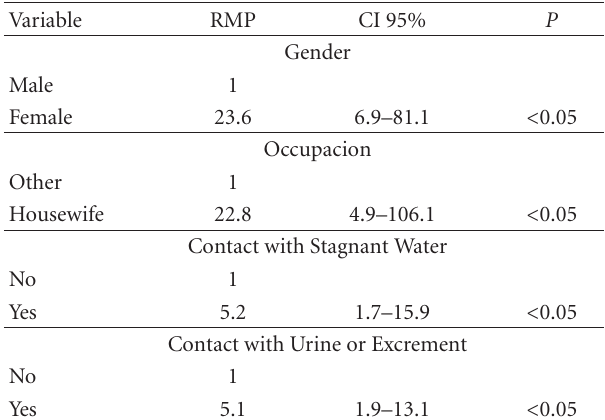
Table 4: Logistic regression model.